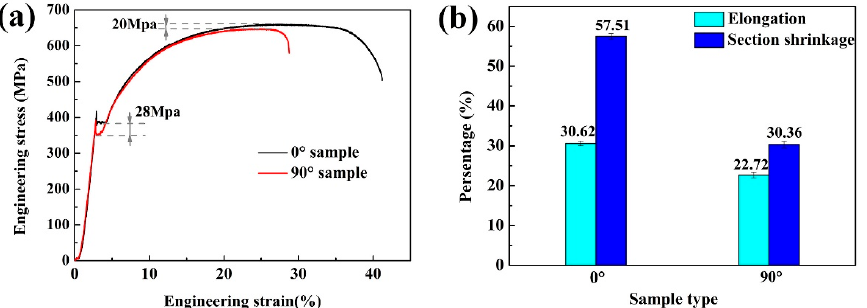
Figure 8. The tensile properties of the hot-rolled bearing steel in the directions 0° and 90°: ( a ) Engi- neering stress-strain curve; ( b ) average plastic elongation and section shrinkage.